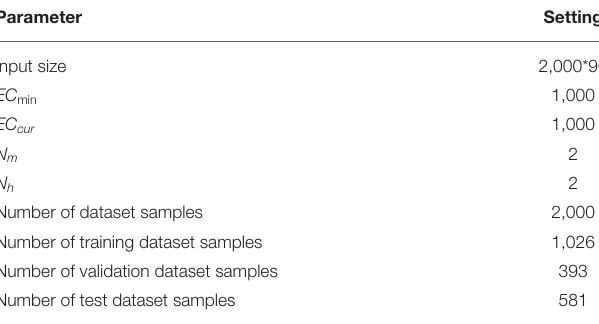
TABLE 1 | Parameters setting for RBFNN.